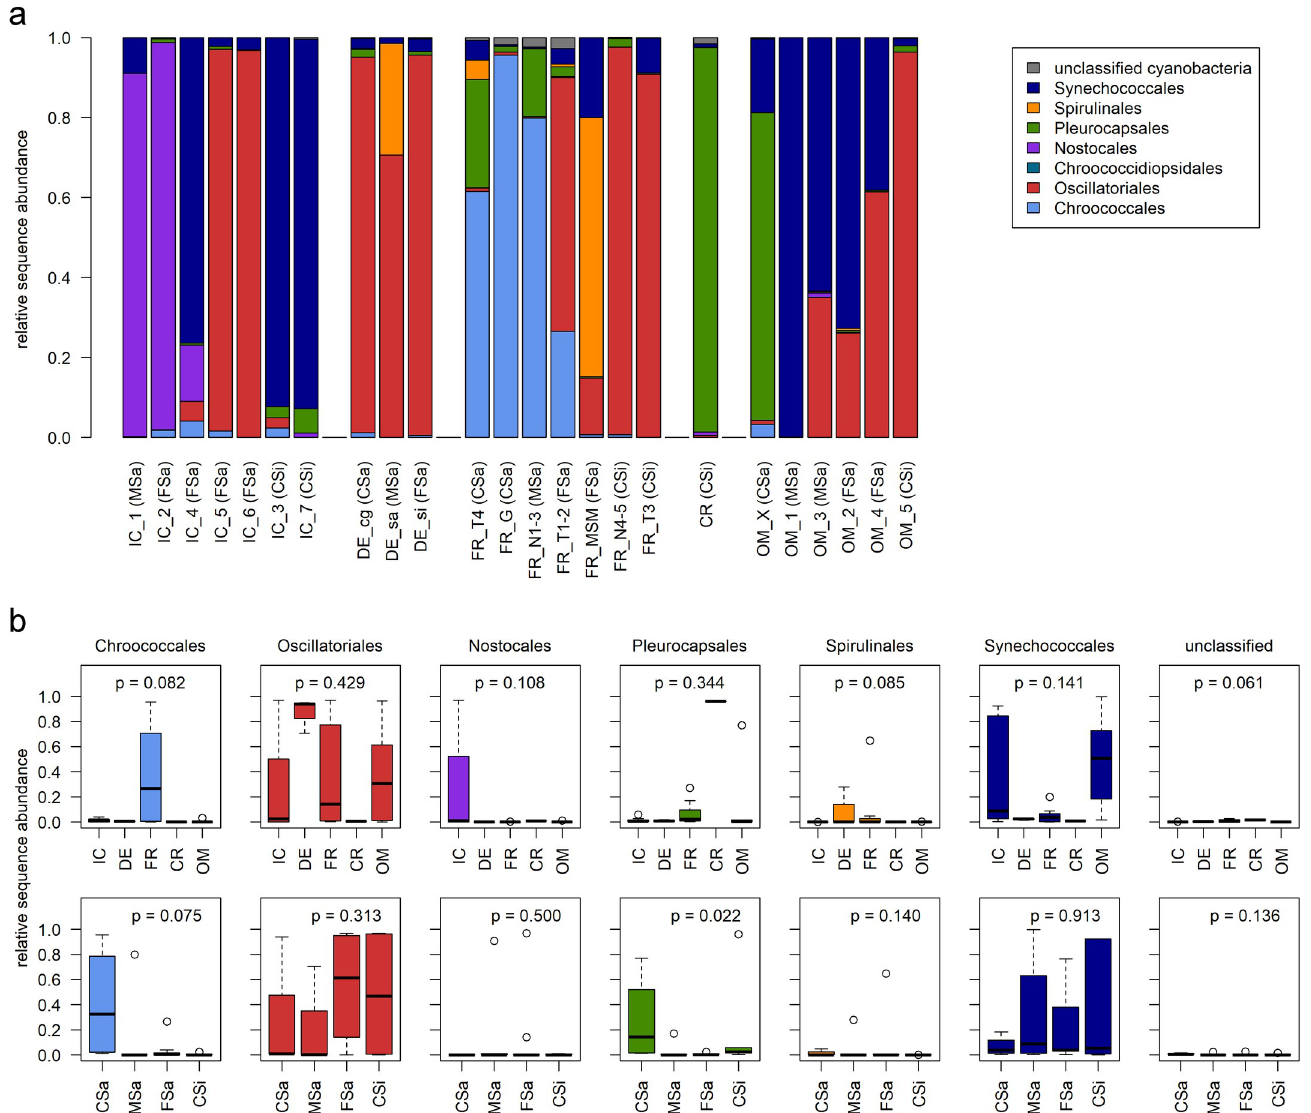
Fig 4. Relative sequence abundance according to taxonomic classification on order level. (a) Relative sequence abundance per sample; samples within each location are sorted according to their mean grain size/sediment type (decreasing); (b) Relative sequence abundance of cyanobacterial orders per location or sediment type; IC = Iceland (n = 7), DE = Germany (n = 3), FR = France (n = 7), CR = Croatia (n = 1), OM = Oman (n = 6); CSa = coarse sand (0.63–2.0mm, n = 4), MSa = medium sand (0.2–0.63mm, n = 5), FSa = fine sand (0.063–0.2mm, n = 9), CSi = coarse silt (0.02–0.063mm, n =